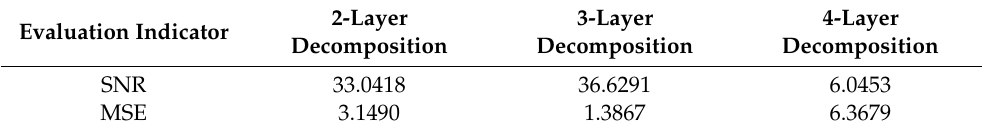
Table 1. The MSE and SNR of different decomposition levels under the signal.